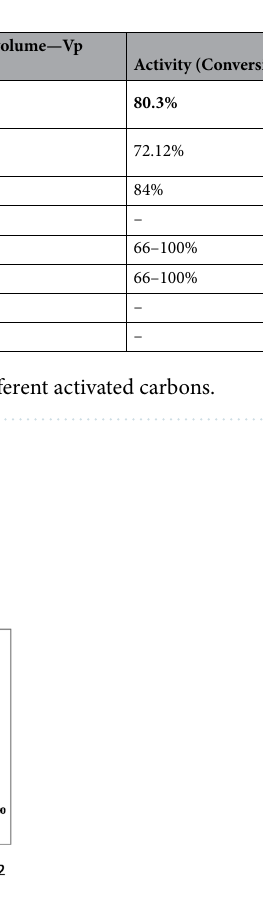
Figure 5. For acid activated carbon ( a ) N 2 adsorption–desorption isotherm ( b ) Pore size distribution.